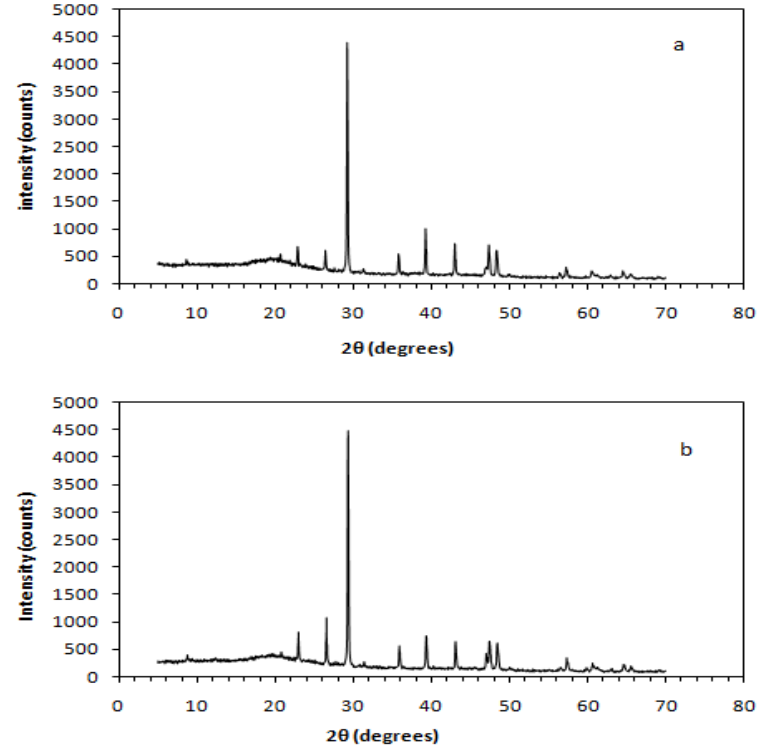
Figure 9. X-ray diffractograms of polyester resin matrix composites ( a ) 300 µ m composites and ( b ) 500 µ m